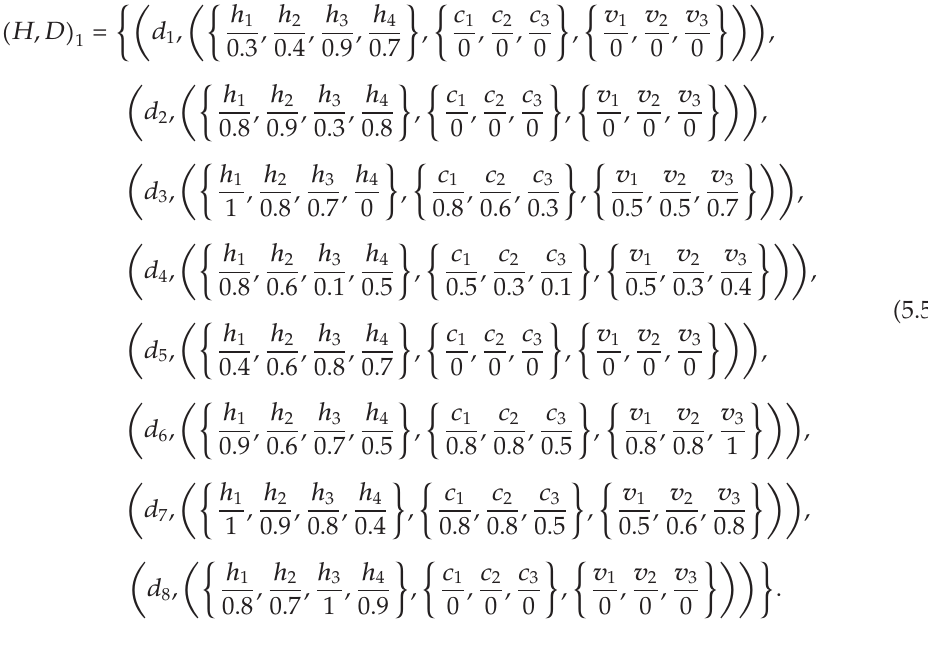
1 -fuzzy soft multiset part of h 2